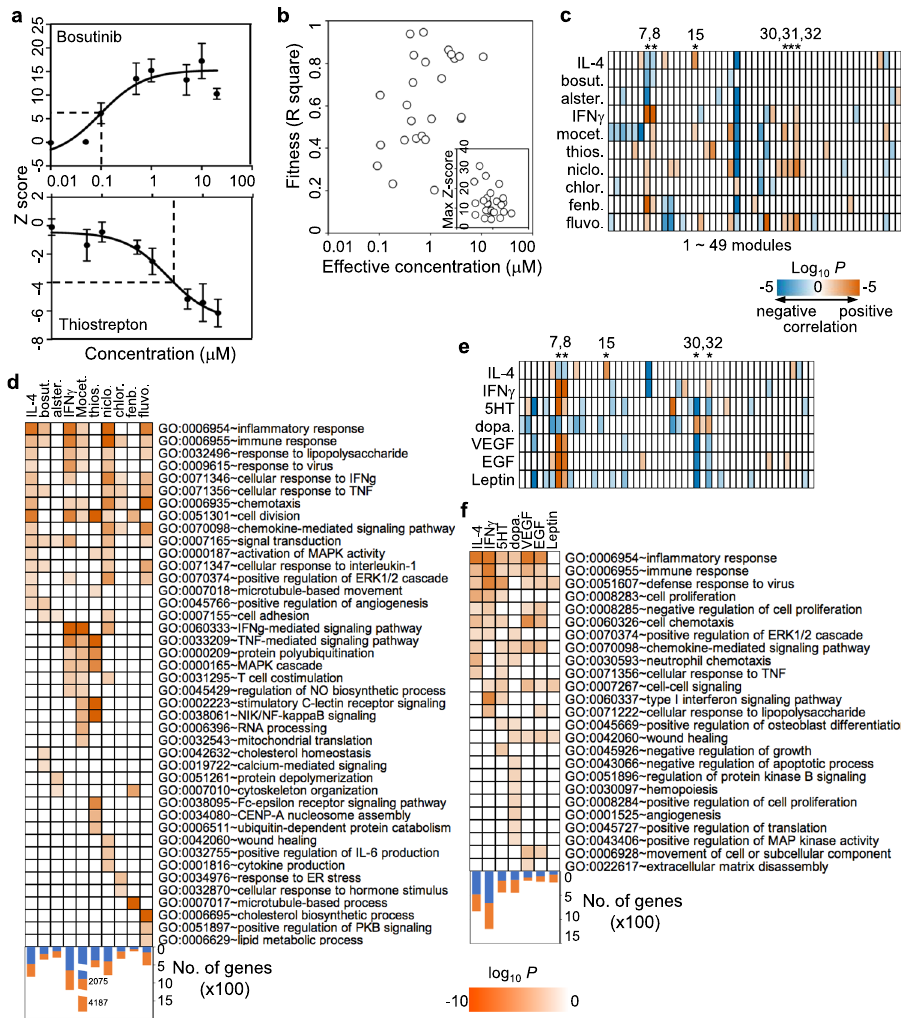
Fig. 2 Validation of macrophage activation induced by compounds or by ligands of the identi fi ed new pathways. a , b Morphology changes induced by selected compounds are dosage dependent. Dosage responses were calculated based on the measurement of Z -scores at different concentrations of the compound in a Michaelis – Menten model. Shown are dosage response curves of M1-activating (thiostrepton, n = 6) and M2-activating (bosutinib, n = 4) compounds ( a ). Data are presented as mean ± sem. Overall, 25 of the 30 tested compounds had typical dosage-dependent response ( b ). Effective concentration (EC) was de fi ned as the concentration of compounds inducing cell morphology changes to reach the cutoffs of either M1 or M2. EC, fi tness ( R 2 ), and max Z -score were calculated by the Michaelis – Menten equation. Data were summarized from three independent experiments. c GSEA of transcriptional responses to eight selected compounds and controls (IL-4 and IFN γ ). Duplicate hMDM samples were treated with two M2-activating and six M1-activating compounds as well as IL-4 and IFN γ for 24 h. Gene expression levels were measured by RNA-seq separately. GSEA preranked analysis was performed based on the whole genome gene list ranked on gene expression changes using a gene set of 49 transcriptional modules in response to 29 stimuli in hMDMs 6 . bosut.: bosutinib, alster.: alsterpaullone, mocet.: mocetinostat; thios.: thiostrepton, niclo.: niclosamide, chlor.: chlorhexidine, fenb.: fenbendazole, fl uvo.: fl uvoxamine. The numerical numbers at the top indicate module numbers identi fi ed by Xu et al. 6 . d GO enrichment analysis of DEGs induced by each compound and positive controls. The numbers of DEGs that are upregulated (orange) and downregulated (blue) are indicated. e GSEA of transcriptional responses to six ligands of the identi fi ed new pathways in Fig. 1h. dopa.: dopamine, 5HT: serotonin. Duplicate hMDM samples were stimulated with each ligand and analyzed by RNA-seq separately. f GO enrichment analysis of DEGs induced by the ligands and positive controls. The numbers of DEGs that are upregulated (orange) and downregulated (blue) are